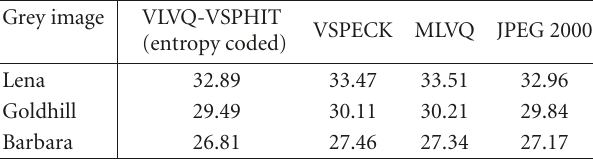
Table 1: Performance comparison at bit rate 0.2